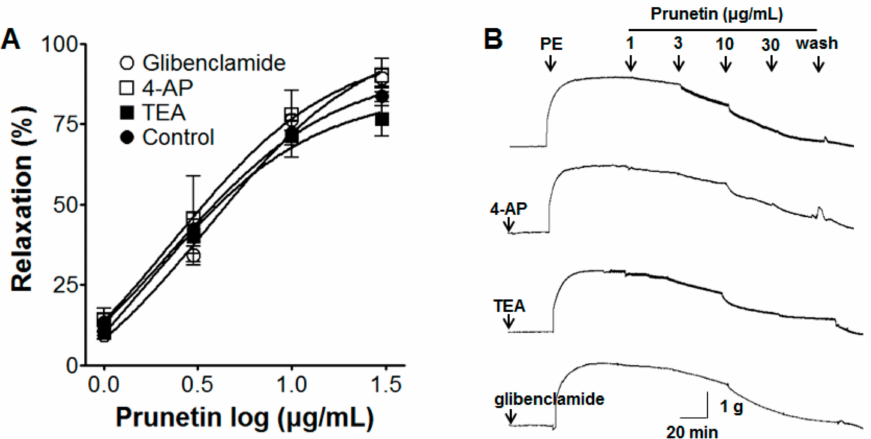
Figure 5. Concentration-response relaxation effect ( A ) and representative traces of the effect ( B ) of prunetin on endothelium-intact aortic rings pre-contracted by phenylephrine (PE, 1 µ M) with or without (control) glibenclamide (K ATP channel blocker, 10 µ M), 4-aminopyridine (K V channel blocker, 4-AP, 1 mM), or tetraethylammonium (BK Ca channel blocker, TEA, 5 mM). Values are expressed as mean ± SEM ( n = 4–6).